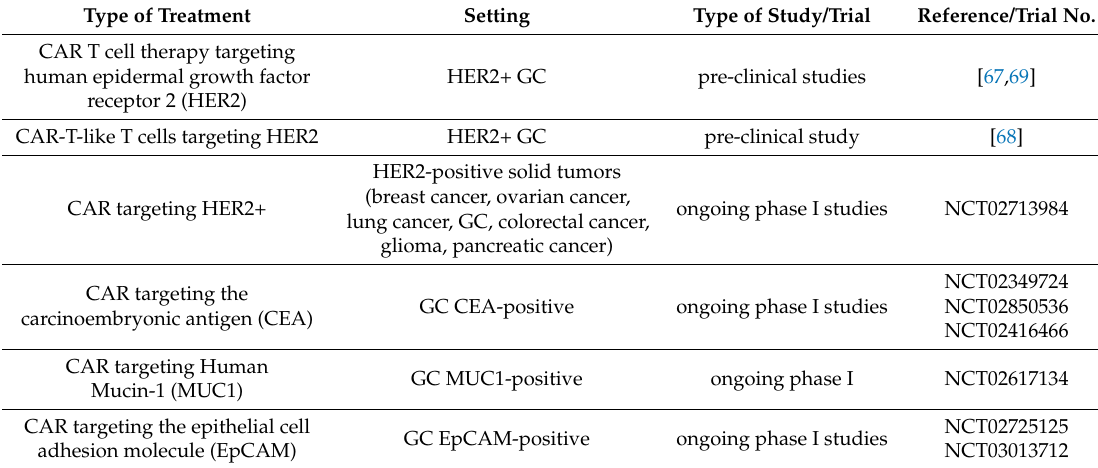
Table 3. Engineered adoptive T/NK cells—CAR-T